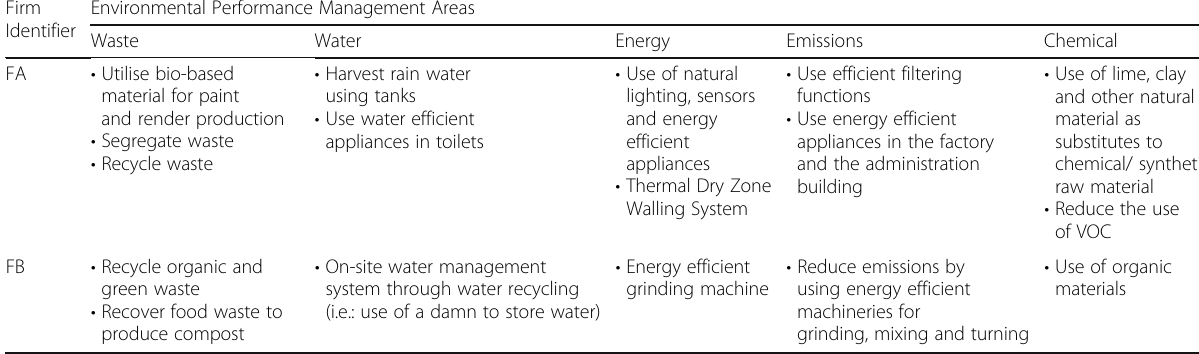
Table 4 Environmental performance across the two case study SMEs Firm Environmental Performance Management Identifier